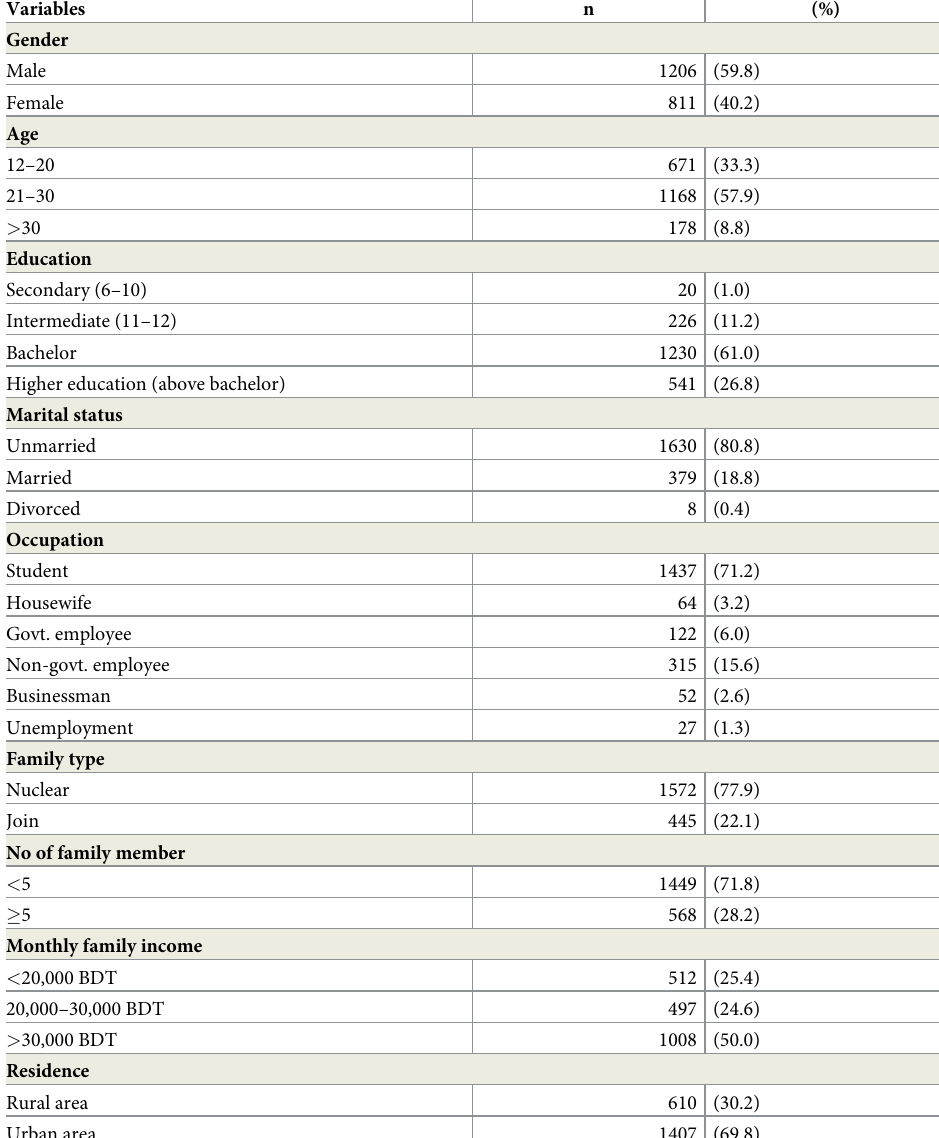
Table 1. Demographic characteristics of participants (N =